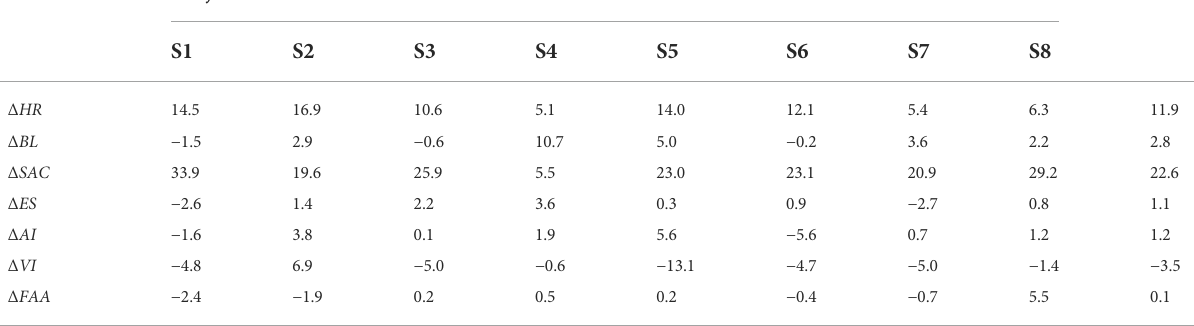
TABLE 2 Difference between the average metrics in the exploration/ fi ght condition to the average metrics over the baseline condition for each subject and averaged over all subjects. Δ